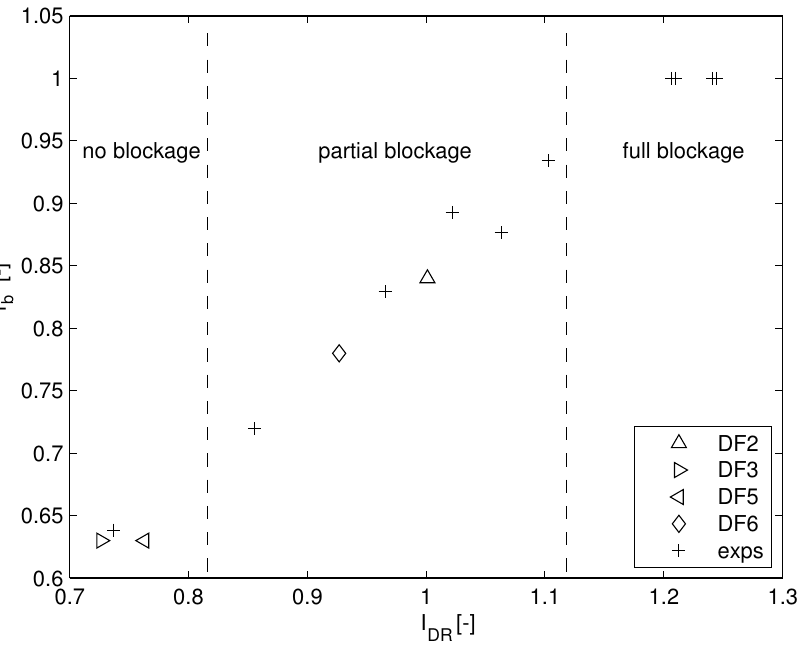
Figure 9. The sediment deposit resilience index I DR is plotted versus the obstruction ratio r b for the experimental data and for the field data referring to the debris flows deposits DF2, DF3, DF5, and DF6 observed from the aerial photos of the Minjiang river after the debris flows triggered by the 14 August 2010 rainfall (Tang et al.